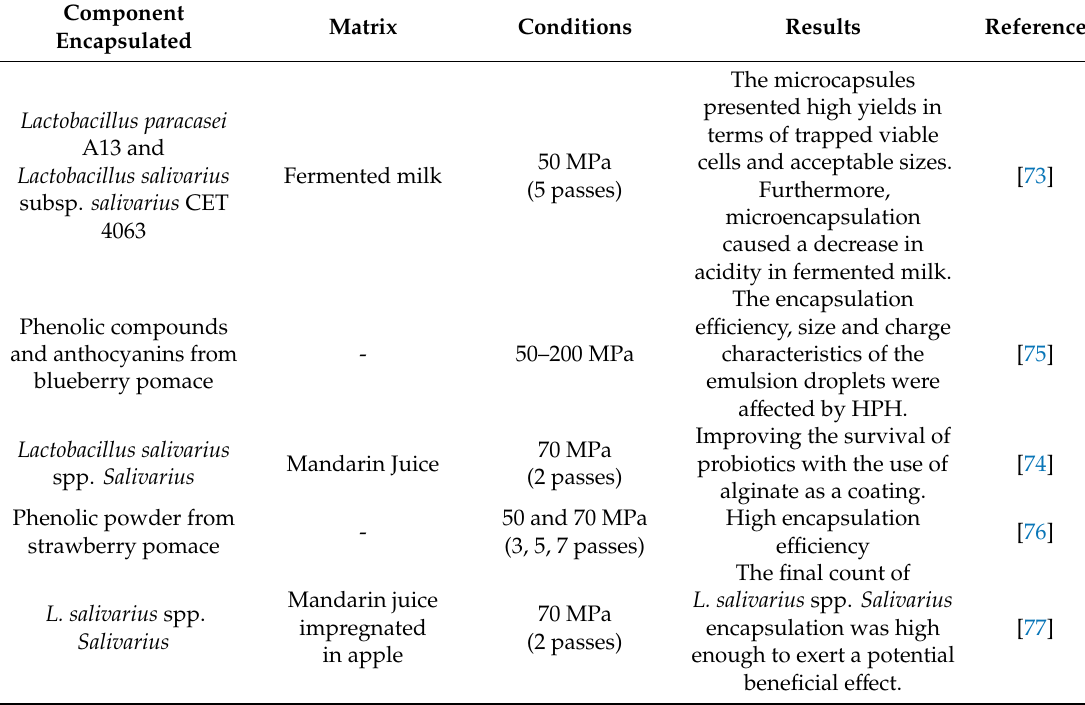
Table 4. Research works in which HPH treatment was applied to